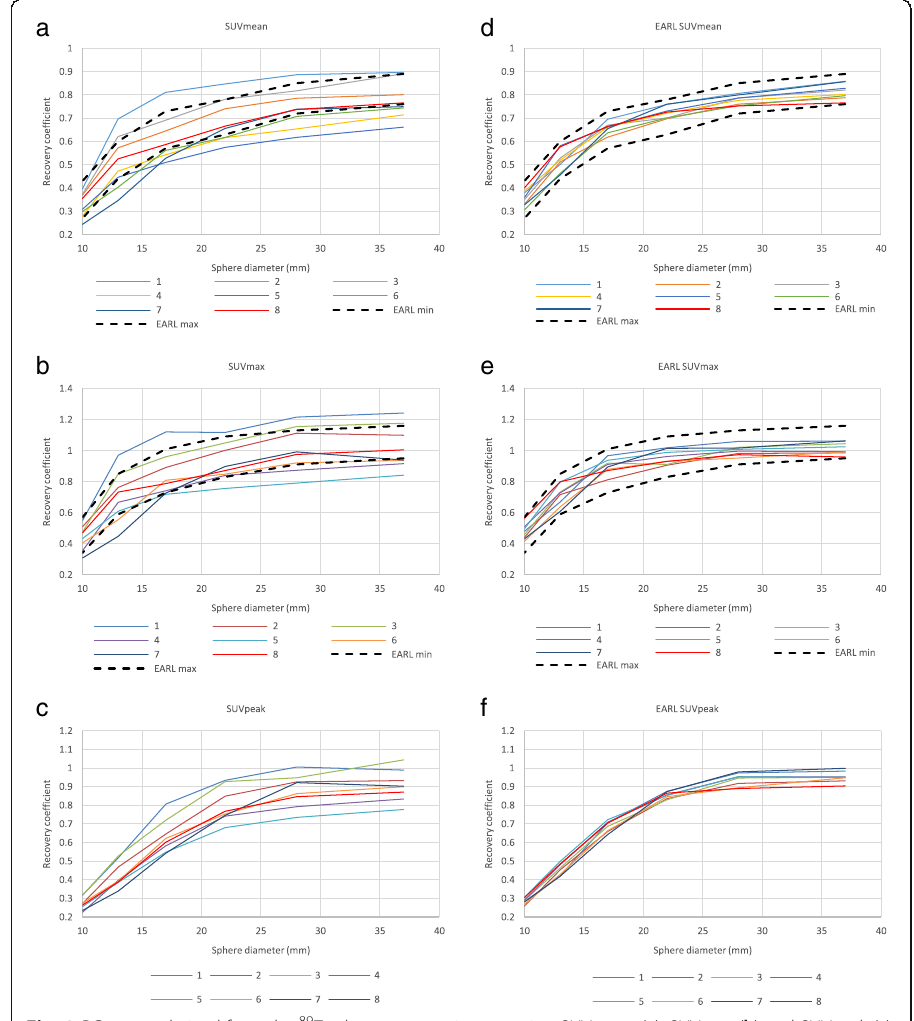
Fig. 3 RC curves derived from the 89 Zr phantom experiments using SUVmean ( a ), SUVmax ( b ) and SUVpeak ( c ) quantitative metrics and corresponding RC curves derived from the EARL [ 18 F]FDG phantom experiments using SUVmean ( d ), SUVmax ( e ) and SUVpeak ( f ) quantitative metrics. Current EARL specifications for [ 18 F]FDG-PET/CT accreditation are presented as bold dashed lines. Systems 1 – 2 and 3 – 4 represent GE scanners Discovery 690 and Discovery 710, respectively; systems 5 – 6 are Siemens Biograph 40_mCT and Somatom Definition AS_mCT; system 7 is the Philips Ingenuity TF PET/CT; system 8 is the Siemens Biograph